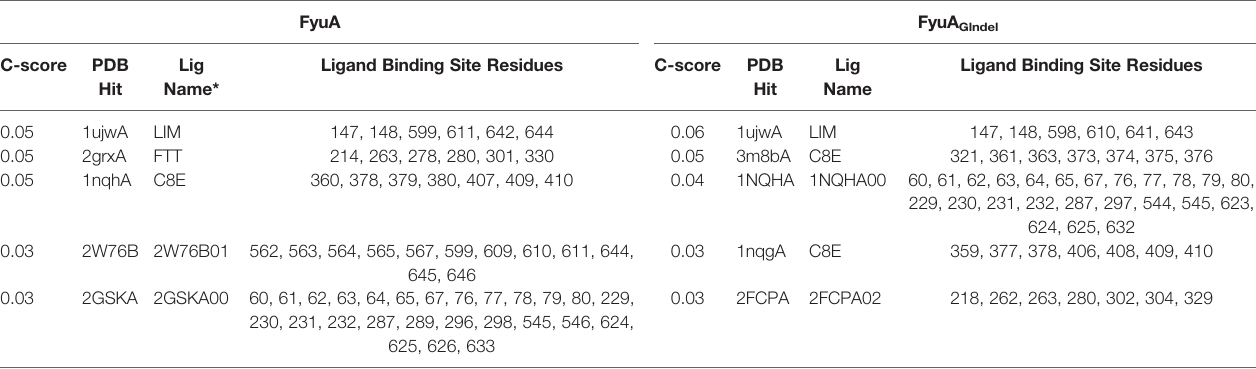
TABLE 1 | The ligand binding site of FyuA and FyuA Glndel .